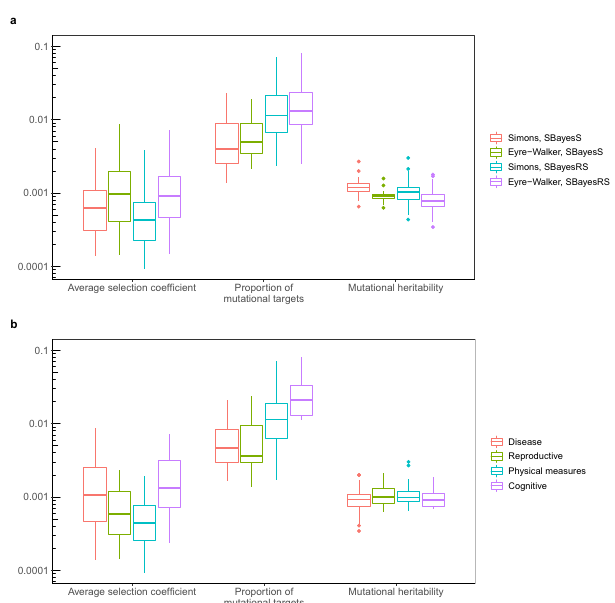
Fig. 5 Prediction of the evolutionary parameters for 44 complex traits and diseases based on a negative selection model where selection coef fi cients followed a mixture distribution. a Distribution of the predicted evolutionary parameters under different scenarios: methods used for estimating the genetic architecture parameters (SBayesS and SBayesRS) and pleiotropic effect models used for simulations (the Simons et al. and Eyre-Walker model), shown by colours. Each box plot shows the results for 44 complex traits. b Distribution of predicted evolutionary parameters for four trait categories, shown by colours. Each box plot shows the results for a number of traits in a category, with each trait having four results from analyses using different estimation methods and simulation